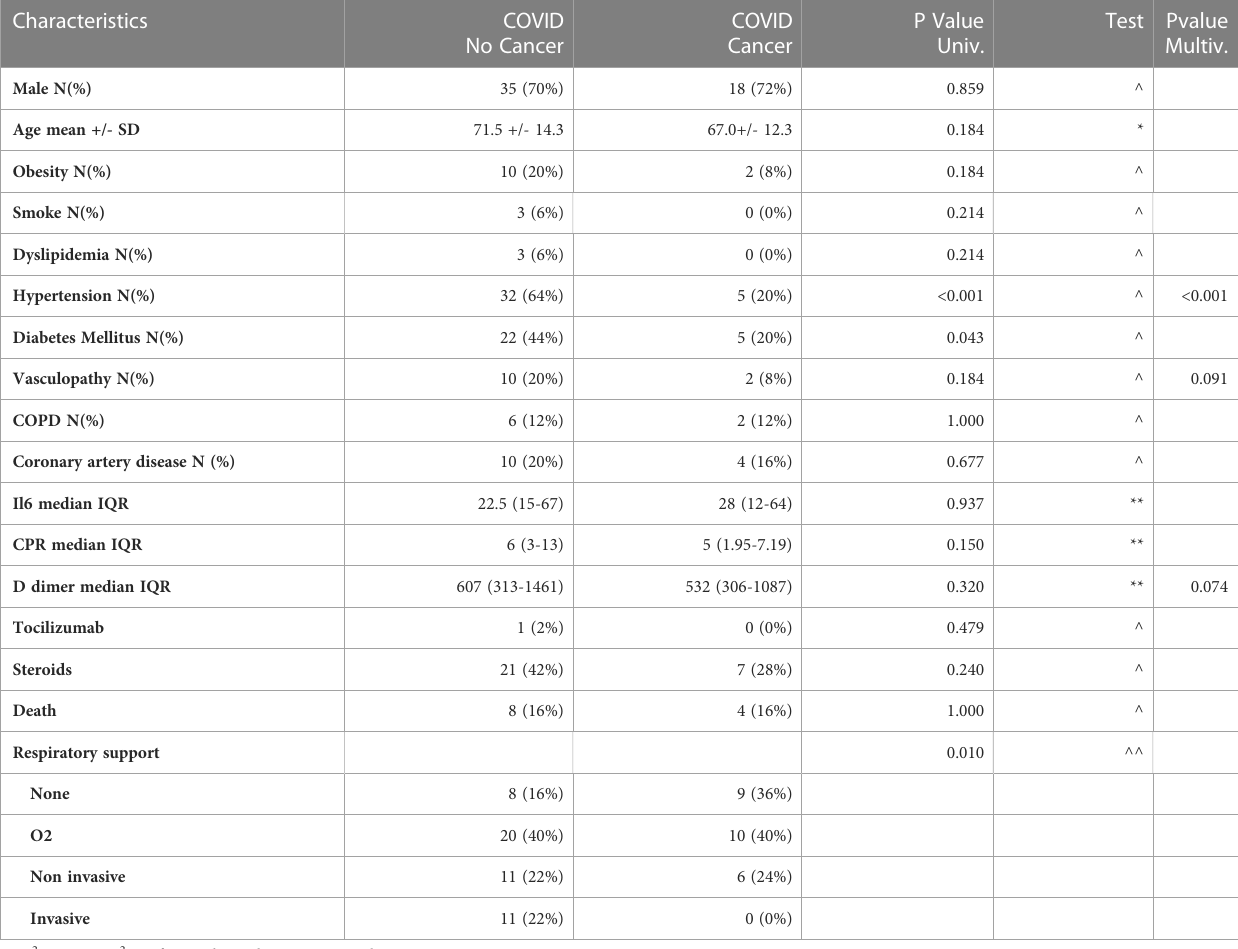
TABLE 1 Demographics and clinical characteristics of patients infected with SARS-CoV-2, with and without oncological disease, involved in the study. Characteristics COVID